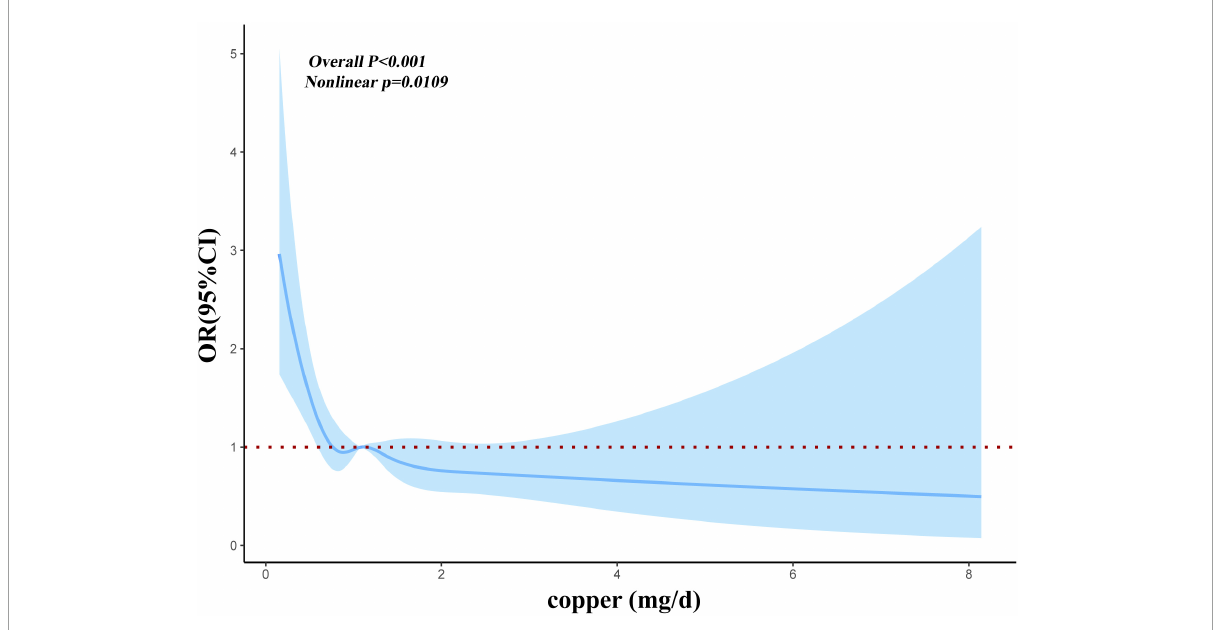
FIGURE2 Restricted cubic spline models for the relationship between dietary copper intake and the risk of myocardial infarction before matching.